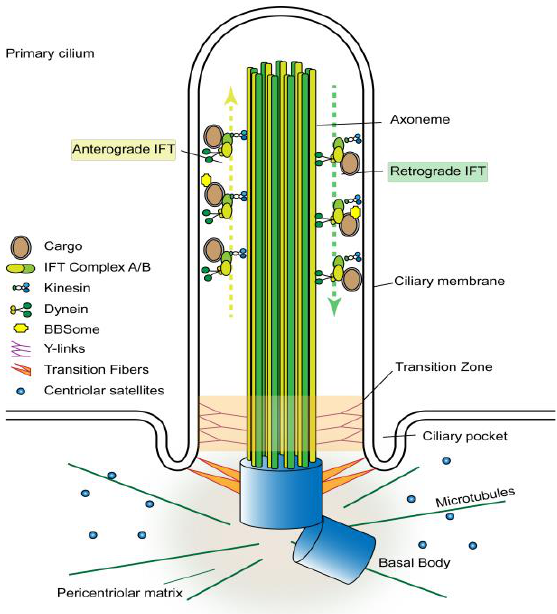
Figure 1. Structure of the primary cilium. The primary cilium is a solitary cell surface protrusion composed of a microtubule-based core (axoneme) ensheathed by an extension of the plasma membrane. The axoneme contains nine pairs microtubules emanating from the basal body located at the base of the cilium. The proximal ends of axonemal microtubules are tethered to the ciliary membrane by Y-links, which form the transition zone. The ciliary compartment is separated from the cytoplasm by transition fibers connecting the basal body microtubules to the ciliary membrane. The basal body also serves as a microtubule organization center that attracts pericentriolar proteins and microtubules. The transition fibers are the docking site of intraflagellar transport (IFT) particles (IFT-A / B), which carry proteins into the ciliary compartment. The loading of protein cargos to the IFT particles is mediated by BBSome. Anterograde IFT moves proteins along the axonemal microtubules from the base to the tip of the cilium and is propelled by the KIF3 kinesin motor complex, whereas, retrograde IFT transports proteins from the tip to the base of the cilium and is driven by the cytoplasmic dynein motor complex.